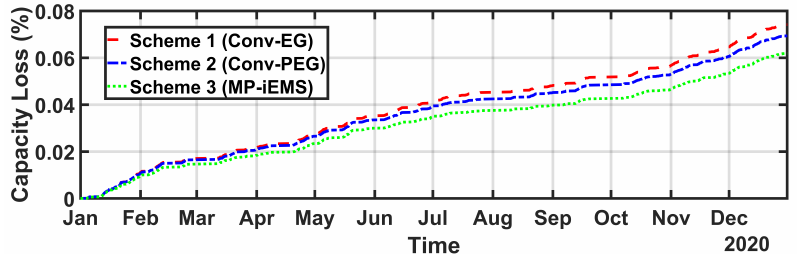
Figure 21. Comparison of total capacity loss.